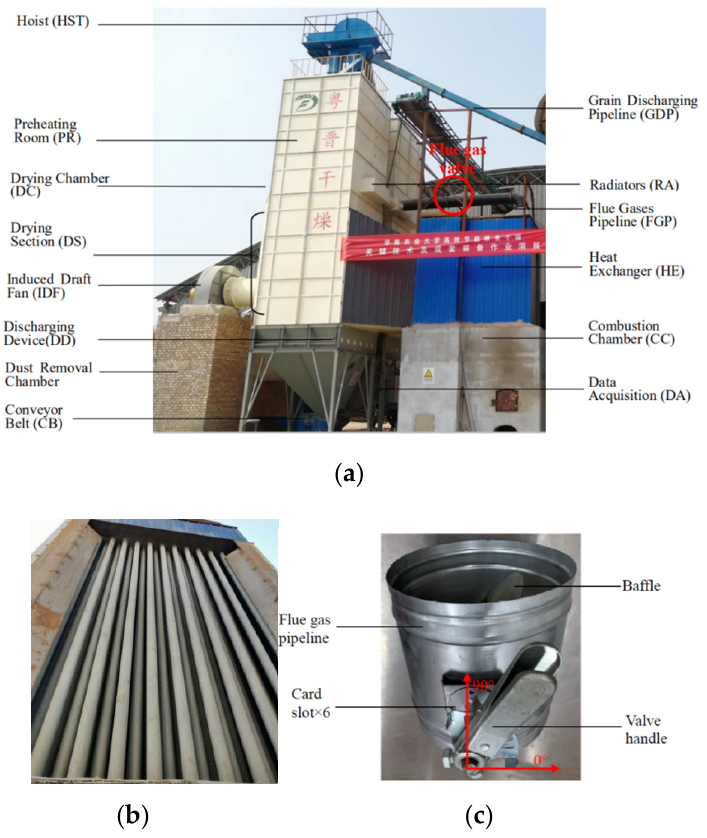
Figure 1. The scene graph of the drying system ( a ), the heat exchanger ( b ) and the flue-gas valve ( c ).